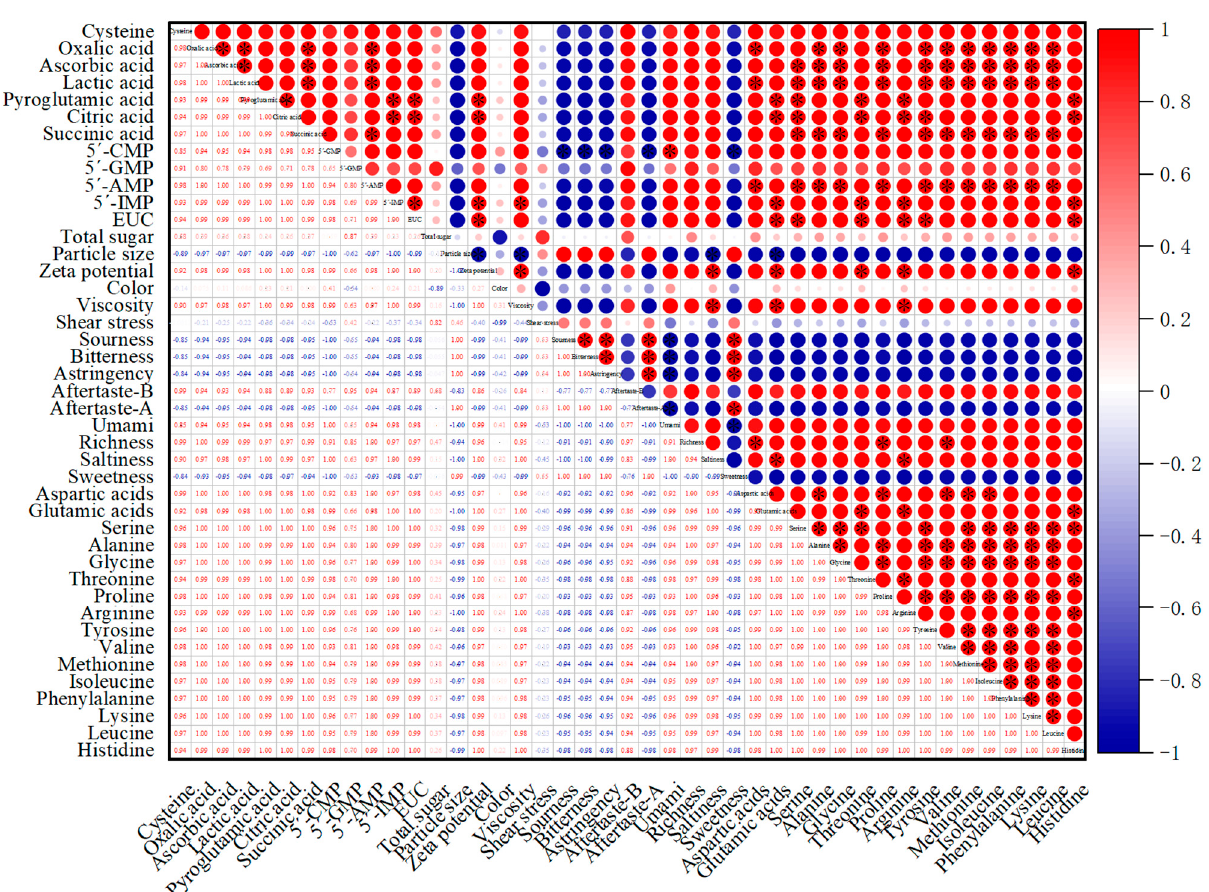
Figure 2. Correlation analysis of EUC, chemical properties, and sensory properties (* represents p < 0.05).